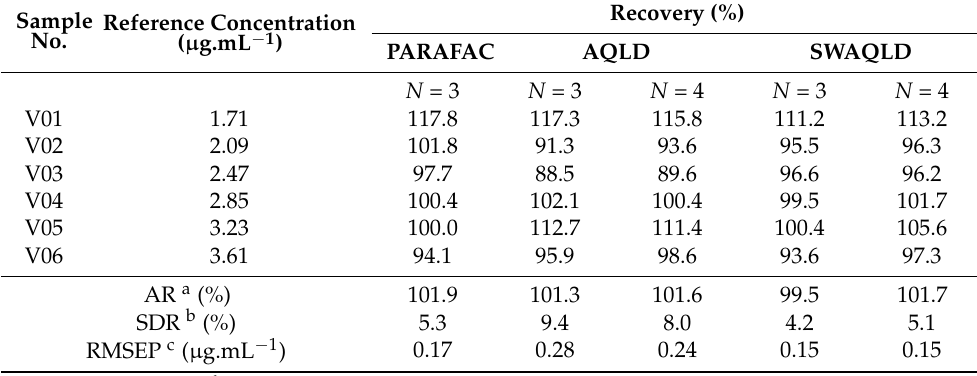
Table 1. Statistical figures of merit concerning the fluorene quantification in free-interference water samples by using third-order calibration methods (PARAFAC, AQLD, and SWAQLD) with different rank